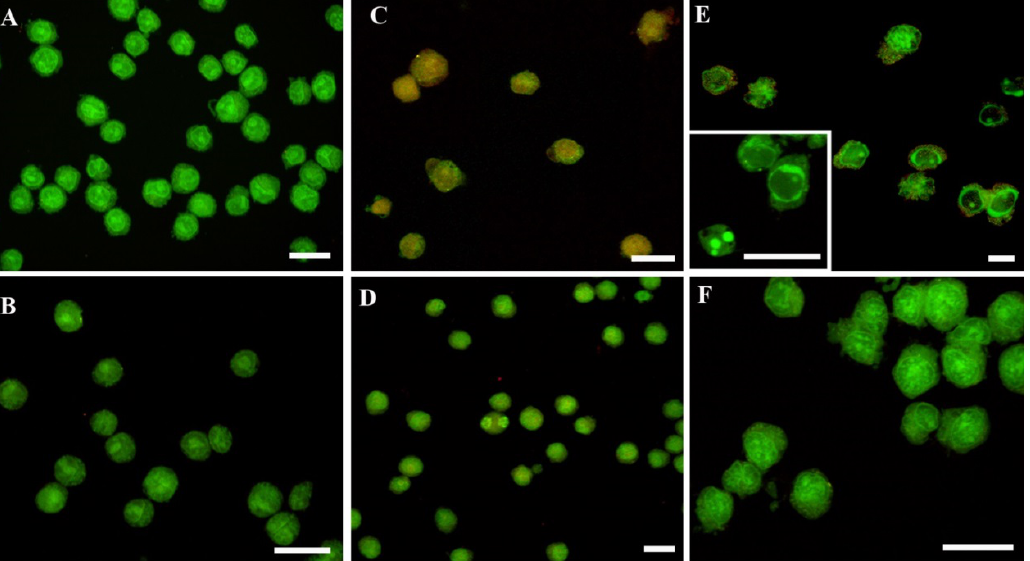
Figure 4. Fluorescent micrographs of AO and PI double-stained U937 cells. Intact green nuclei appear in control ( A ) and MEL alone ( B ) conditions suggesting a good cell viability. After H O ( C ) or staurosporine ( E and inset) exposure apoptotic cells appear and their 2 2 decrease can be observed in MEL pre-treated samples ( D , F ). Scale bars: ( A – F ) 25 µm; ( E and inset) 10 µm.